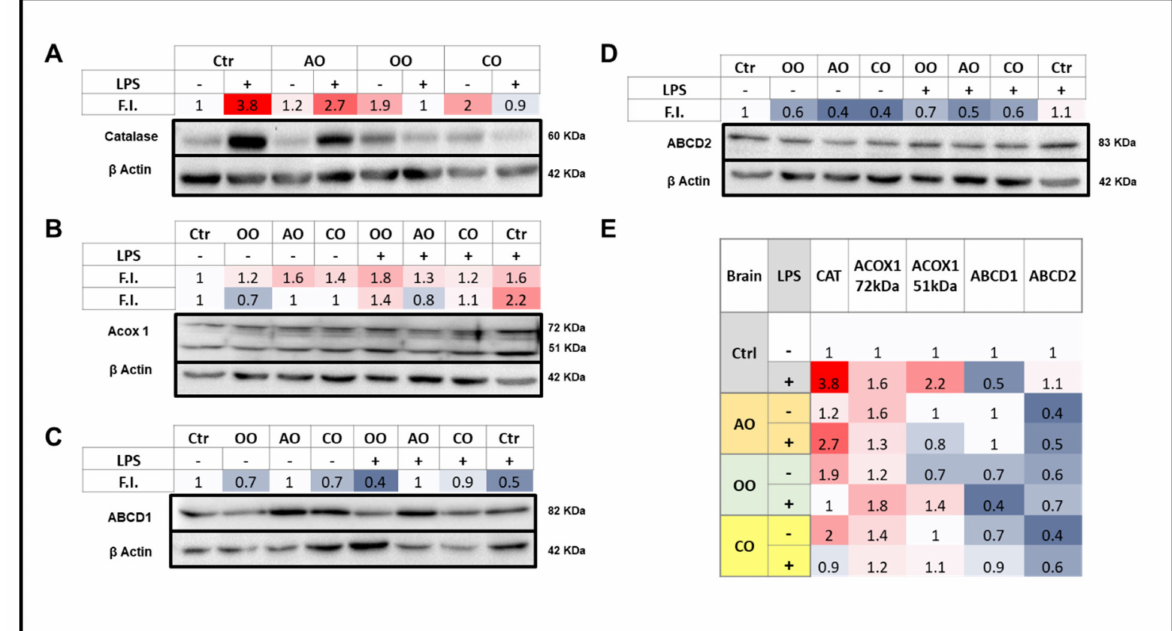
Figure 4. Effect of argan oil, olive oil or colza oil treatment on brain expressions of peroxisomal proteins, CAT ( A ), ACOX1 ( B ), ABCD1 ( C ), ABCD2 ( D ) and the heatmap for all protein expression ( E ). Male C57BL/6 mice received for 28 days a standard diet (control (CTRL)), a diet enriched with 6% ( w / w ) AO, OO, or CO, and intravenous injection of LPS (100 µ g) four hours antemortem. Brain homogenates were separated in PAGE-SDS electrophoresis and subjected to immunoblotting as described in Section 4. Band intensities were analyzed by densitometry and standardized to β -actine expression level. Tables represent the standardized densitometric analysis obtained after signal intensity quantification of different